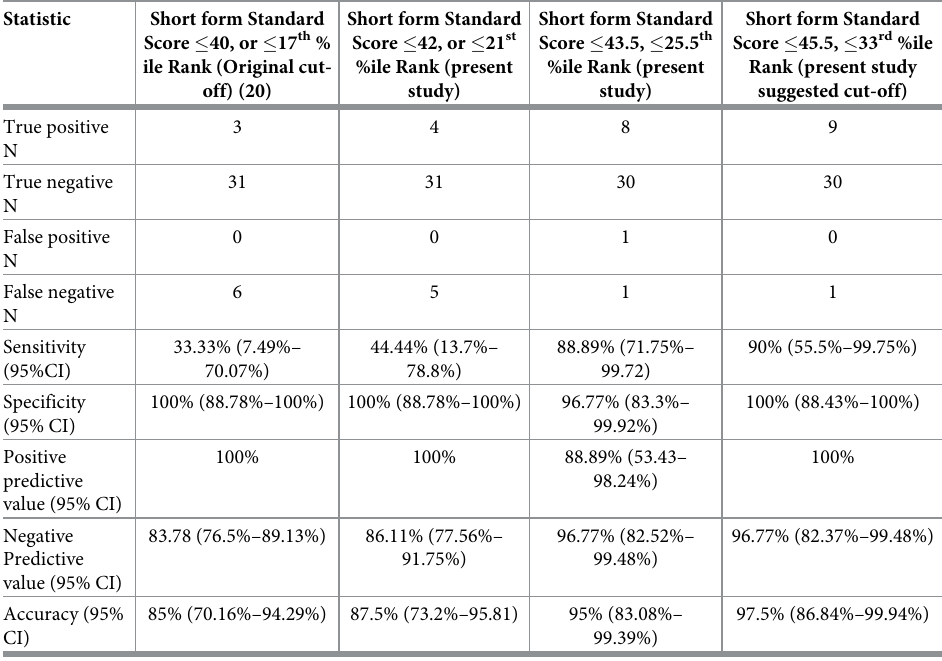
Table 3. Evaluation of BOT-2 short form (SF) scores as a diagnostic test using the original (standard score � 40, or � 17th %ile rank) and different cut-off scores to identify “Below Average for Motor Competency” (n =